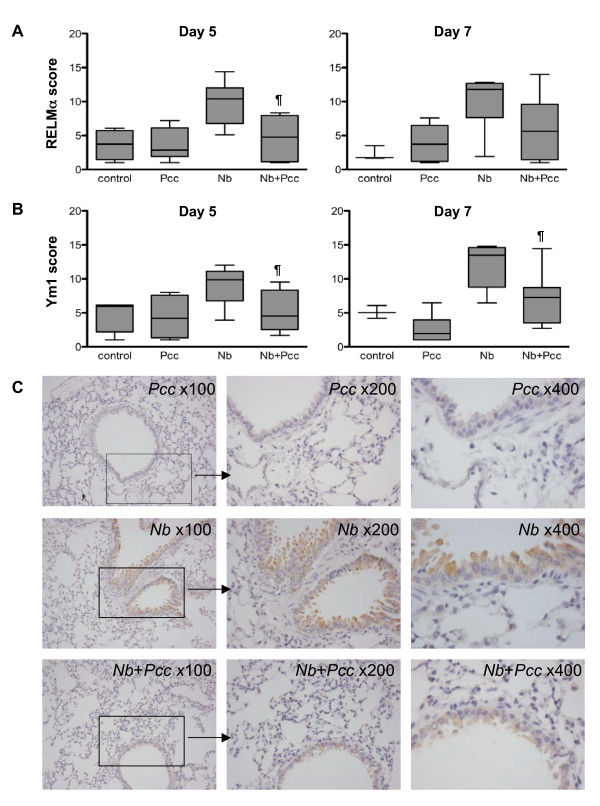
Immunohistochemical analysis of ChaFF protein expression in the lungs of Nb, Pcc and co-infected mice. Protein expression in lung sections corroborated BALF concentrations of ChaFF proteins observed around 7 days pi, as illustrated by days 5 and 7 pi staining intensity scores for RELMα (A) and Ym1 (B) as well as representative micrographs (at increasing magnification) of day 7 pi slides stained for RELMα (C). Down-regulation of ChaFFs was observed in co-infected mice (Nb+Pcc) compared to Nb mice; differences were significant for both RELMα and Ym1 at 5 days pi (RELMα P = 0.0056 and Ym1 P = 0.0153) and for Ym1 at 7 days pi (P = 0.0171). Scores were obtained by analyzing bronchial epithelium in ten fields per mouse using a scoring system described in Methods. The whisker-and-box graphs with minimum and maximum values depict results from a representative experiment with 4-9 mice per group. The symbol ¶ indicates significance of the difference between co-infected and Nb mice (P values included above and in Results text).